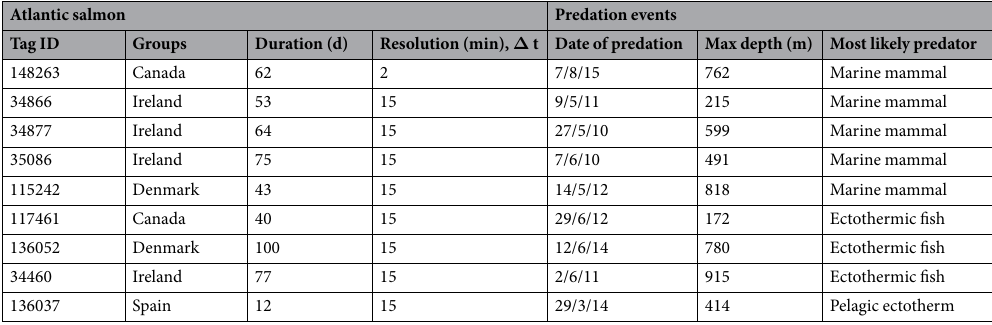
Table 2. Data from tags consumed by marine mammals and ectothermic fish. Duration indicates the time from release until predation. Resolution indicates the temporal resolution of the tag data.